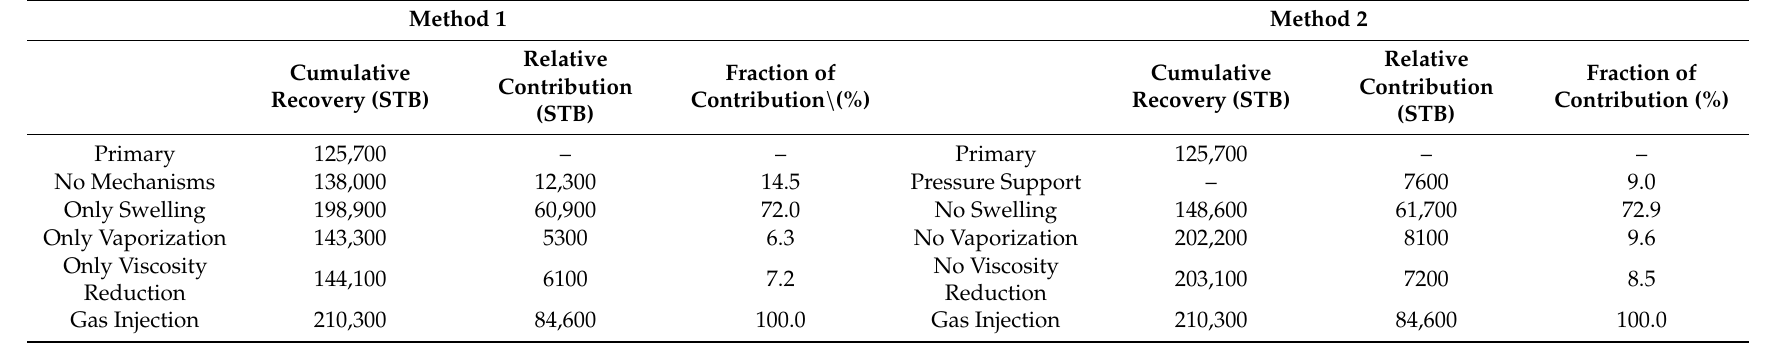
Table 3. Results from simulation runs of 1200 scf / STB oil used to determine the relative contribution of di ff erent